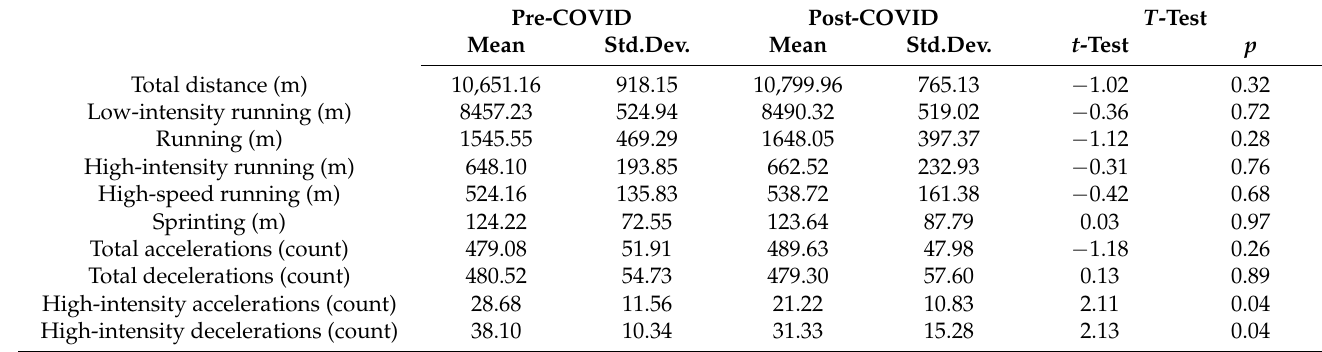
Table 2. Descriptive statistics for match running performances and dependent sample T -test differ- ences within infected players—comparison of the performances before being infected (pre-COVID) and after return to play (post-COVID).